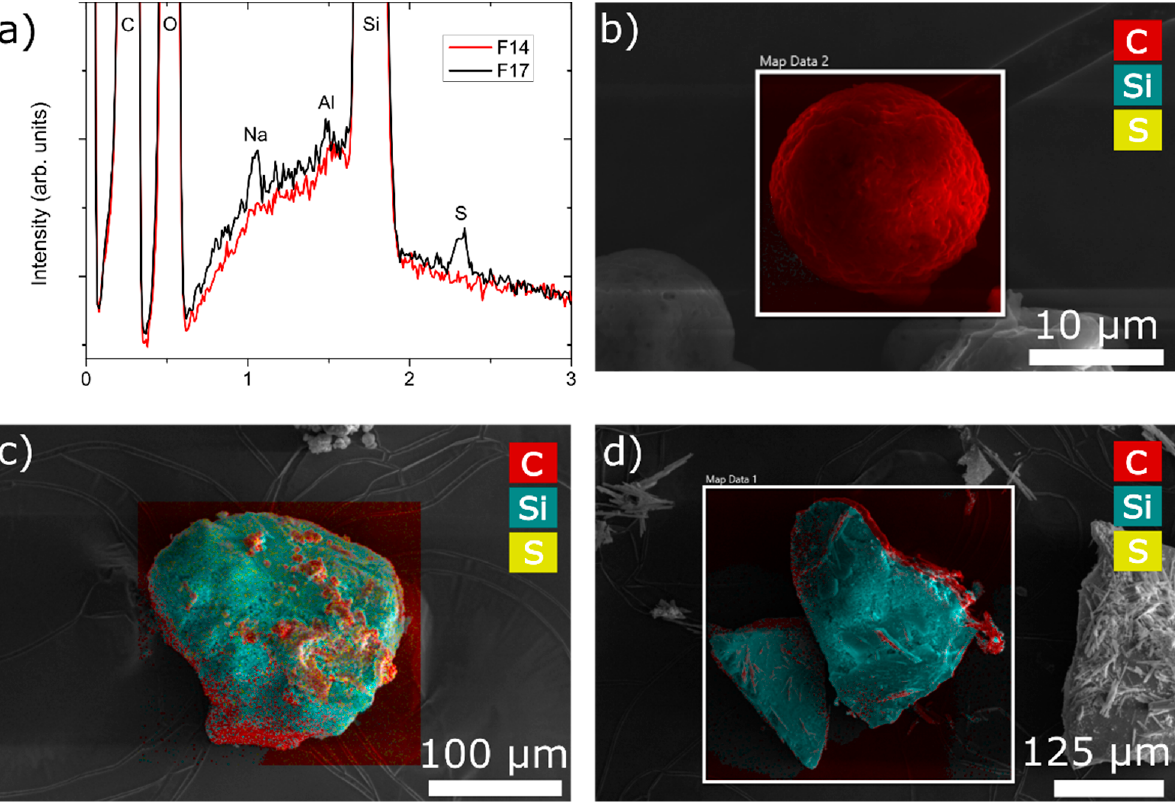
Figure 8. ( a ) Summed EDS spectra of mapping performed on samples F14 and F17; EDS mapping performed on three samples: ( b ) F1; ( c ) F17; ( d ) F14, where red colour represents carbon atoms (HPMC, mannitol), yellow colour represents sulphur atoms (NCC) and blue colour represents silicium atoms (silica).